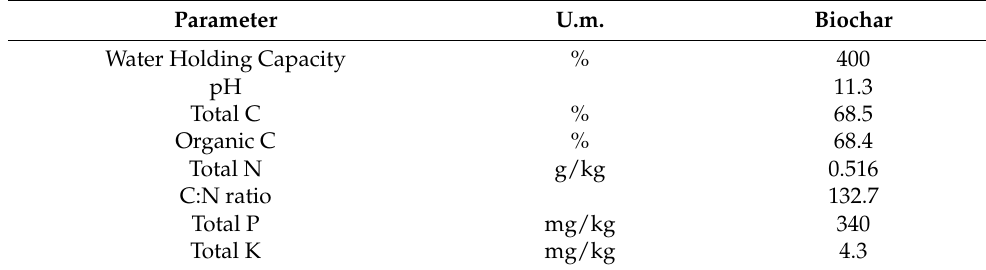
Table 1. Selected characteristics of the biochar used.